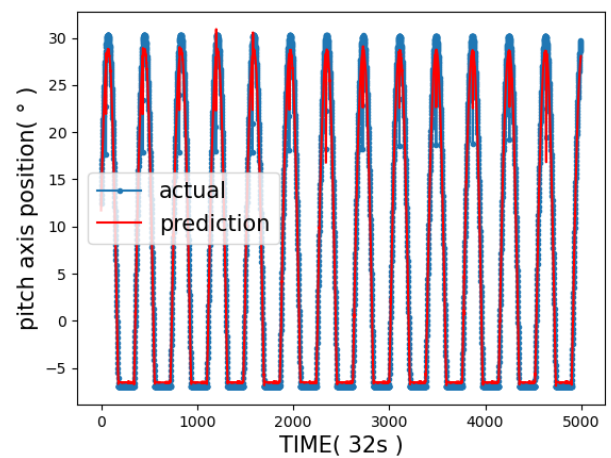
Figure 11. Loss curve for training set and test set.